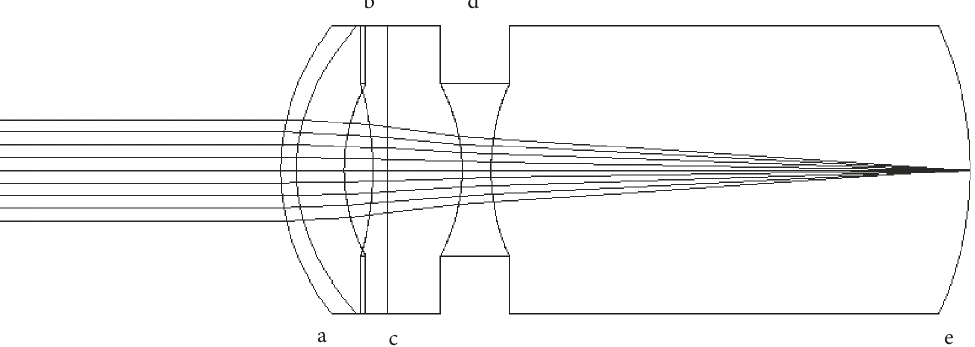
Figure 1: Liou-Brennan eye model with intraocular telescope ITS 1. a, cornea; b, anterior positive lens; c, pupil; d, posterior negative lens; e,